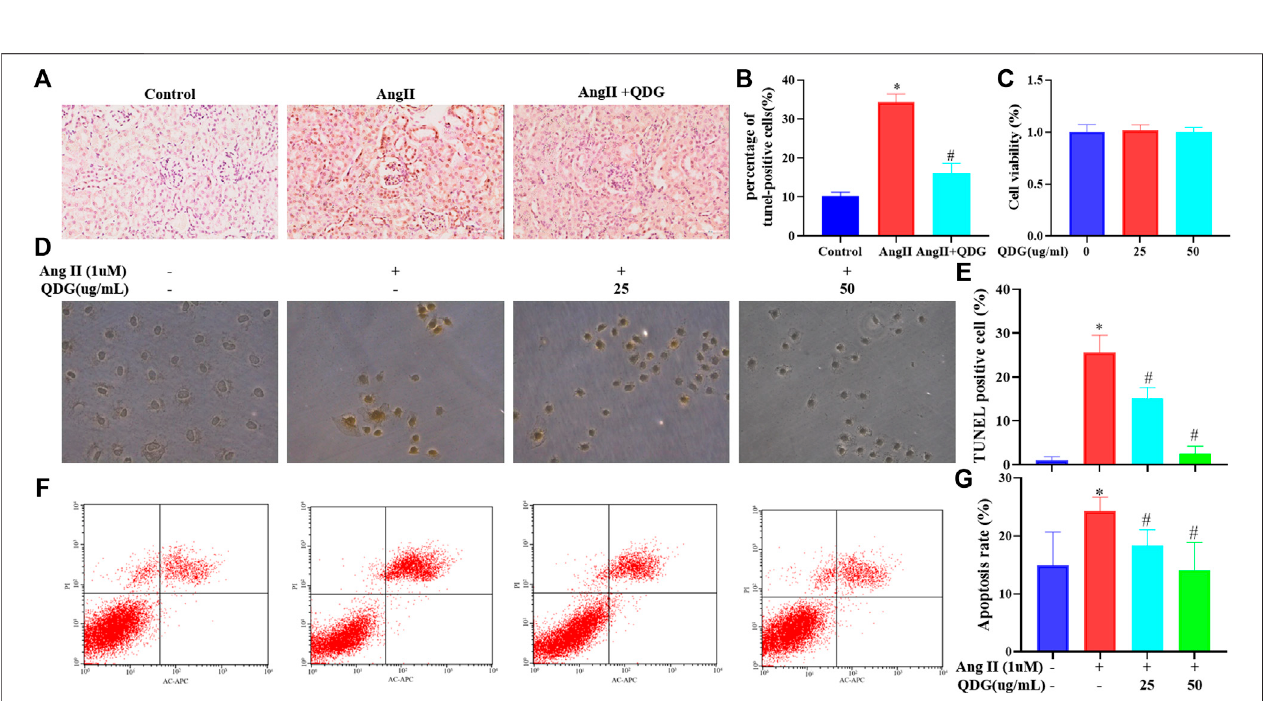
FIGURE 5 | QDG attenuates Ang II-induced renal cell apoptosis in vivo and in vitro . The TUNEL assay was performed to observe cell apoptosis in renal tissues of micefrom each group (A) and thepercentage ofTUNEL-positivecells (B) .Viability ofNRK-52E cellsafter treatmentwithQDG,asanalyzed bytheCCK-8assay (C) .The TUNELassaywasperformedtoobservecellapoptosisinNRK-52Ecellsfromeachgroup (E) andthepercentage ofTUNEL-positivecells (D) .Representativedotplotof Annexin V- and PI-stained cells (F) and a columnar graph that comprised the percentage of apoptosis in NRK-52E cells (G) . Data were presented as mean ± SD; * p < 0.05 vs. the Control group, # p < 0.05 vs. the Ang II group.